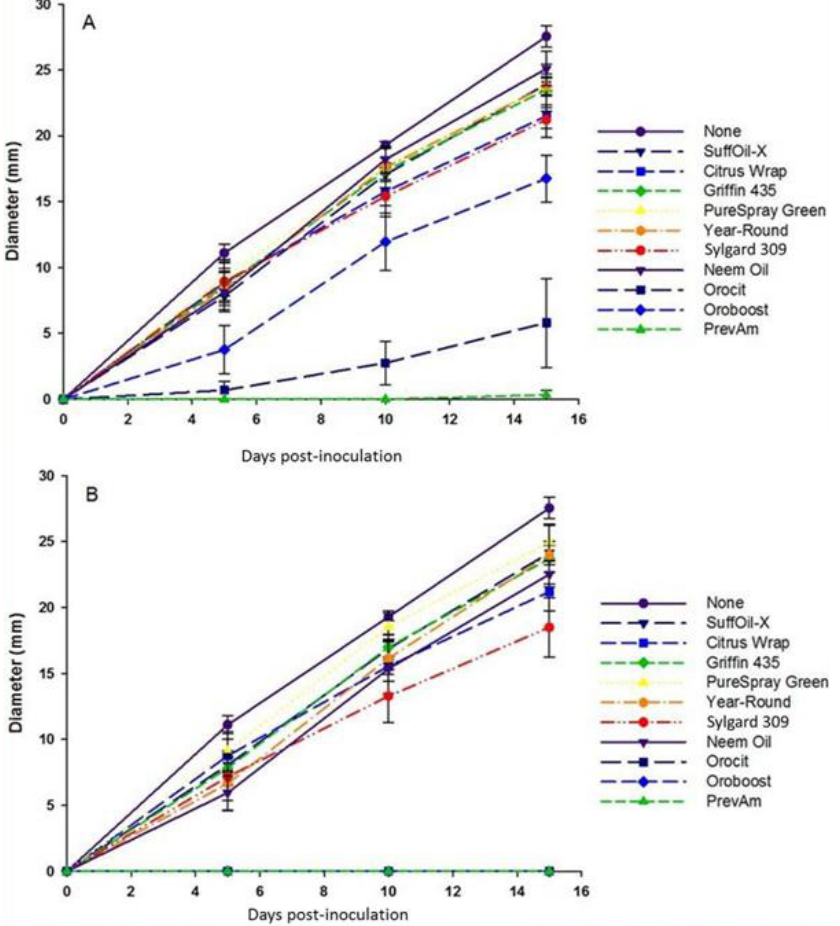
Figure 2. Radial growth estimates for Isaria fumosorosea on PDA treated with spray oils and adjuvants at two rates, i.e. , A = 0.5% v/v, B = 2% v/v. Data are mean ± SEM of four tests (three replicates per test).